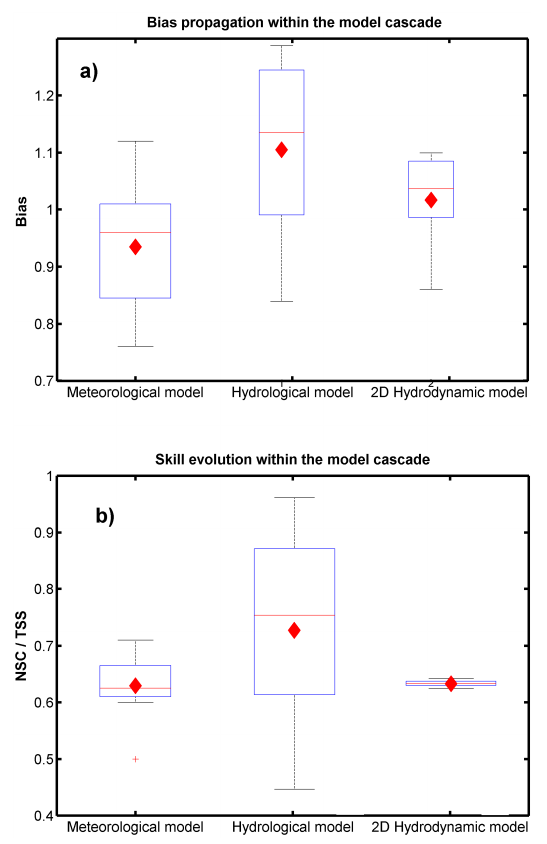
Figure 11. (a) Bias and (b) skill propagation within the model cascade (meteorological–hydrological–hydrodynamic); diamonds: corresponding ensemble mean